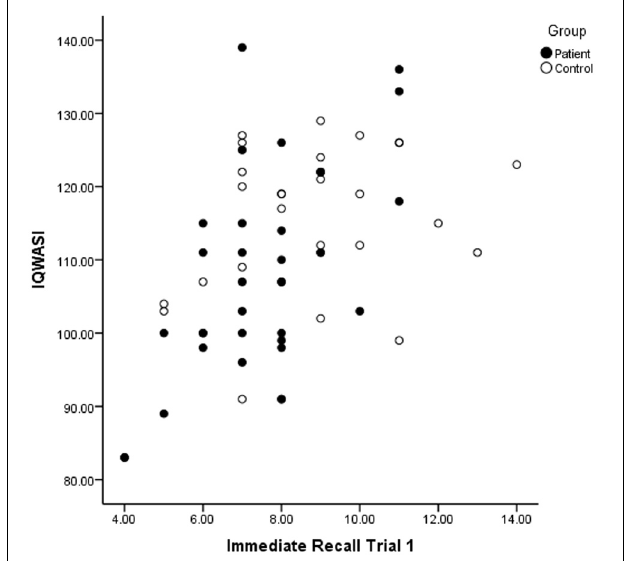
FIGURE 1 | The correlation between IQ and Immediate Recall for patients and